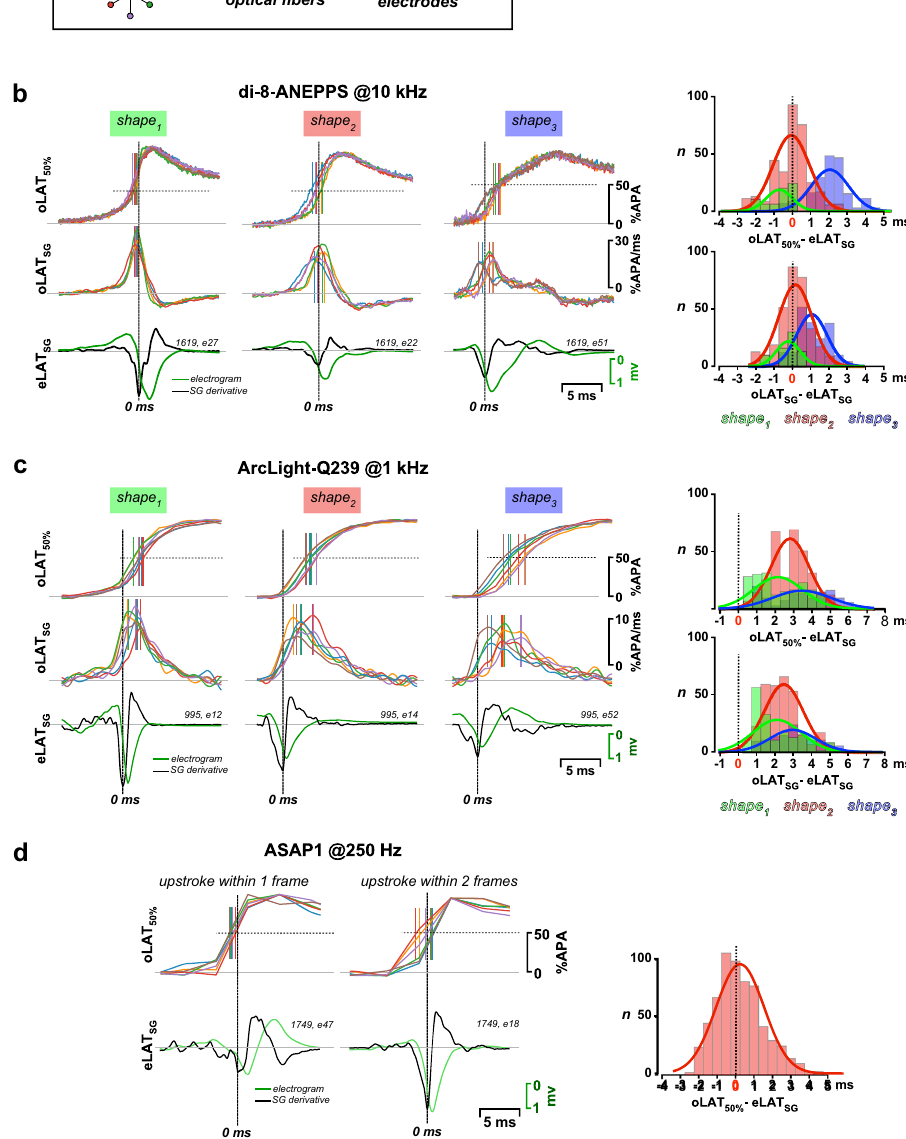
Fig. 6 Concordance of optical and electrical LAT determinations. a Schematic drawing of the sensor layout used for the determination of optoelectrical differences in local activation time (LAT). b Optoelectrical LAT differences for a heart stained with di-8-ANEPPS. Left side, top: example traces of prototypical optical action potential (oAP) upstrokes classi fi ed into shapes 1 – 3 with vertical lines indicating oLAT 50% of each signal. Left side, center: same for SG (Savitzky-Golay) derivatives of the oAPs. Left side, bottom: electrogram of the central electrode (green) with overlaid SG derivative (black) and eLAT SG set to zero. Right side: histograms of optoelectrical LAT differences for oLAT 50% (top) and oLAT SG (bottom) with data being grouped according to shapes 1-3 . c Same as ( b ) for an ArcLight-Q239 expressing heart. d Same as ( b ) for an ASAP1 expressing heart. The low sampling frequency required for ASAP1 precluded meaningful shape classi fi cations and oLAT SG determinations. Source data are provided as a Source Data fi (optical stimulation). As illustrated by the central- and Mercator projections (Fig. 5f), maximal θ e during optical stimulation amounted to 463 mm/s with θ perpendicular to this vector amounting to 324 mm/s (anisotropy ratio: 1.43).